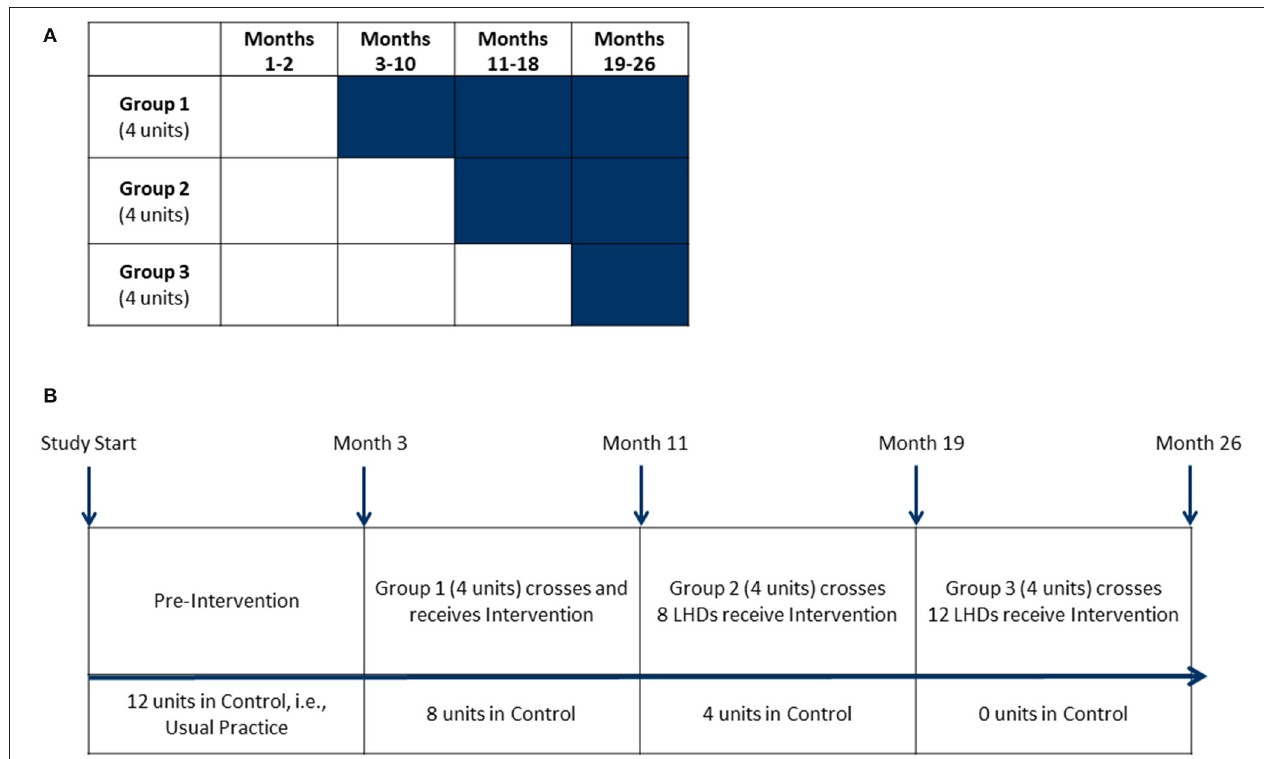
FIGURE 1 | Stepped-wedge design. (A) This stepped-wedge design featured 12 units (local health departments) randomly assigned into one of three groups. Shaded cells represent intervention periods. Clear cells represent control periods. Group 1’s intervention period was 24 months, Group 2’s intervention period was 16 months and Group 3’s intervention period was 8 months. (B) Baseline measures for all units were taken during the pre-intervention period. Groups crossed over from control to receive intervention activities with measurements at 8-month